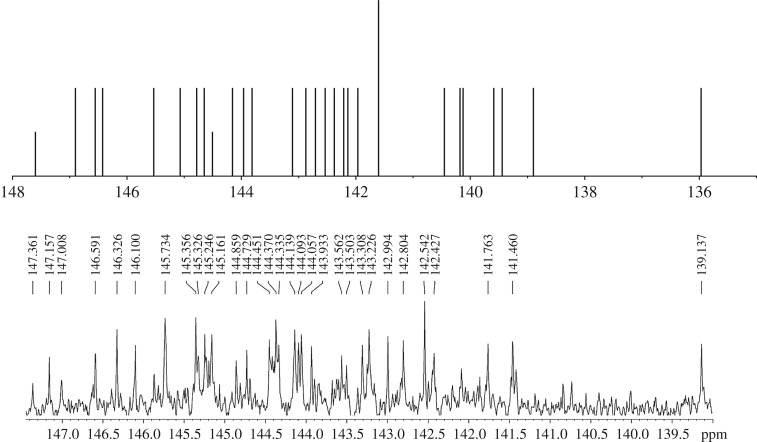
Comparison of the calculated 13C NMR spectrum of the e isomer of C60O2 with the experimental 13C NMR spectrum of peak III.